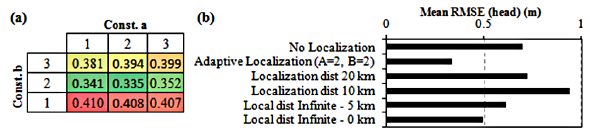
Figure 3. Head RMSE as a function of the adaptive localization constants a and b (a) and head RMSE using different localization methods (b) .